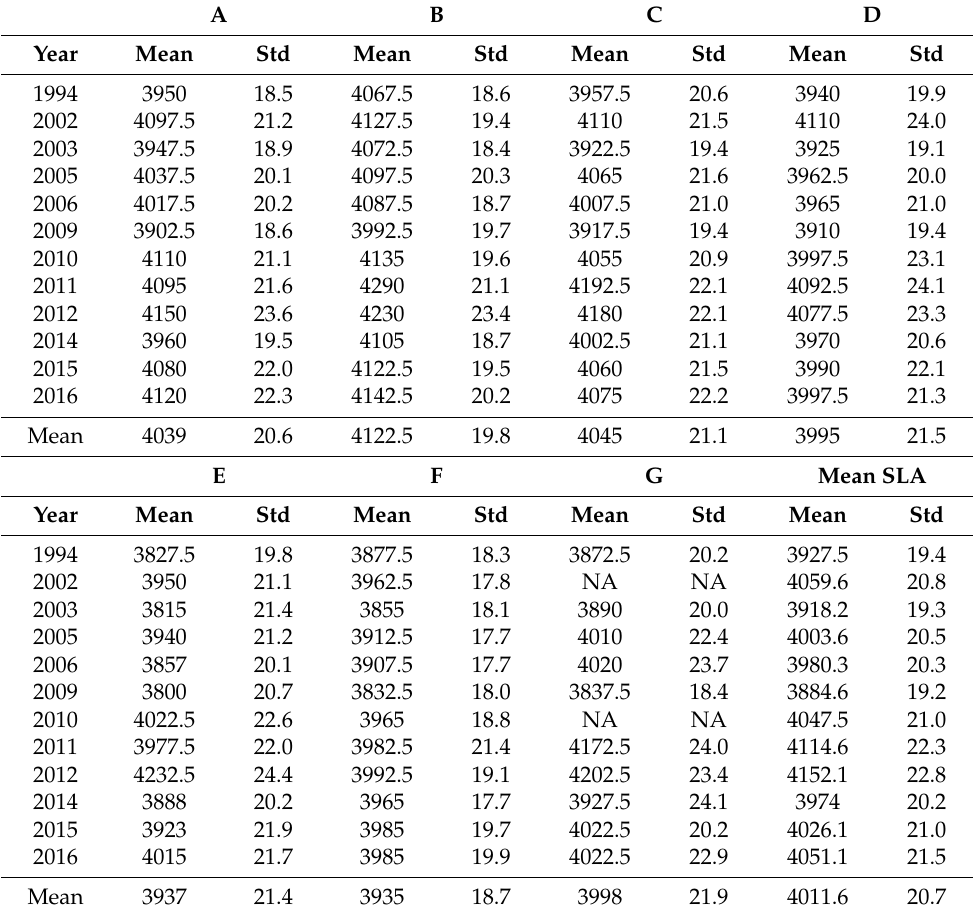
Table 5. Mean and uncertainty (SD) for SLAs on each glacier in the Eastern Tien Shan Mountains extracted from a 2000 ASTER GDEM. The mean SLA, displayed at the bottom right, is the individual glacier mean for each year. The uncertainty of the mean SLA was calculated as an average of population statistics. Labels (A, B, C, D, E, F, G) correspond to glaciers in Figure 1. A B C D